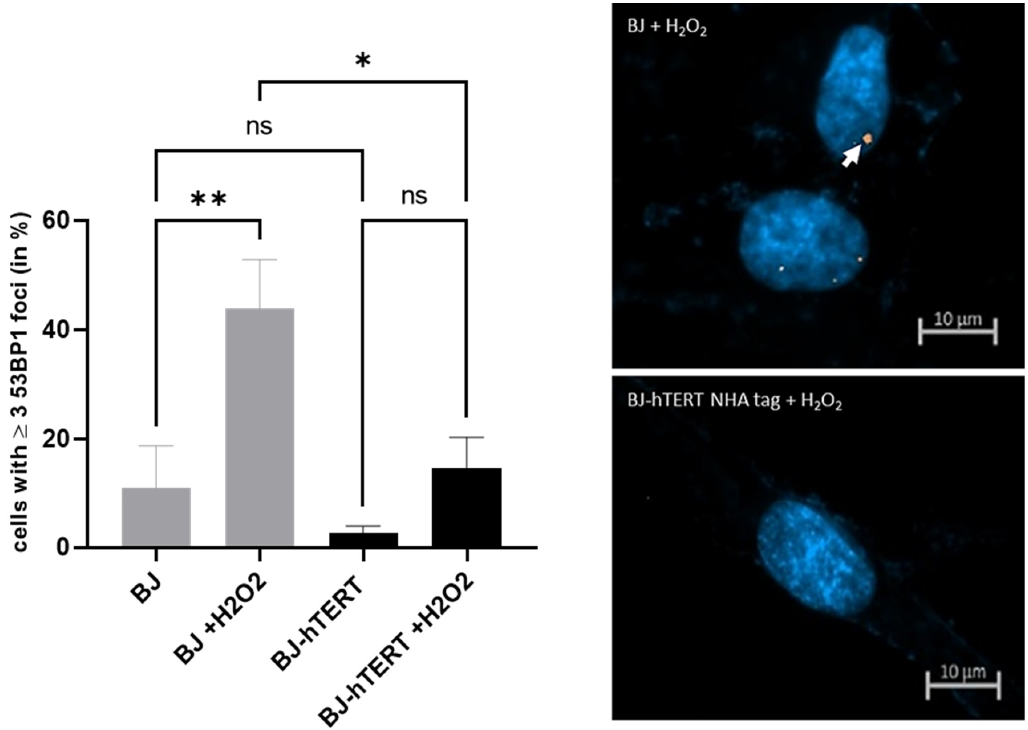
Figure 9. Evaluation of 53BP1 foci formation upon ROS-induced replication stress. ( Left ) The bar plot displays the impact of H 2 O 2 treatment on 53BP1 foci formation in BJ and BJ-hTERT cells. One-way ANOVA test was applied, followed by a Fisher’s LSD post hoc test, with a confidence interval of 95%. ( Right ) Representative images from BJ (top) and BJ-hTERT (bottom) treated with H 2 O 2 . A total of 170 cells were counted from n = 4 independent experiments. The representative pictures show DAPI-stained nuclei with nuclear pRPA2 foci (white arrow). ns ( p > 0.05), * ( p ≤ 0.05), ** ( p ≤ 0.01).